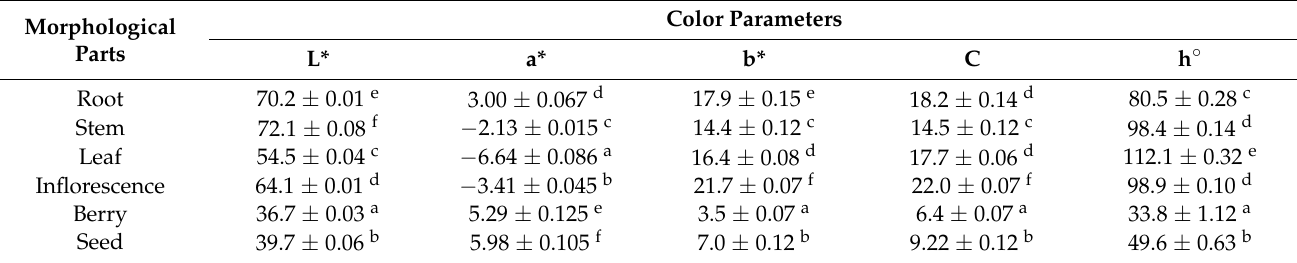
Table 5. The results of color analysis characteristic of A. cordata morphological